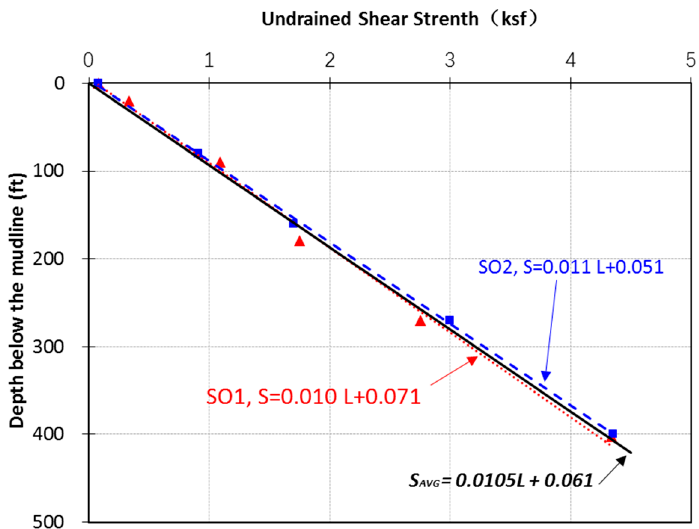
Figure 2. The profile of average shear strength based on SO1 and SO2 holes.